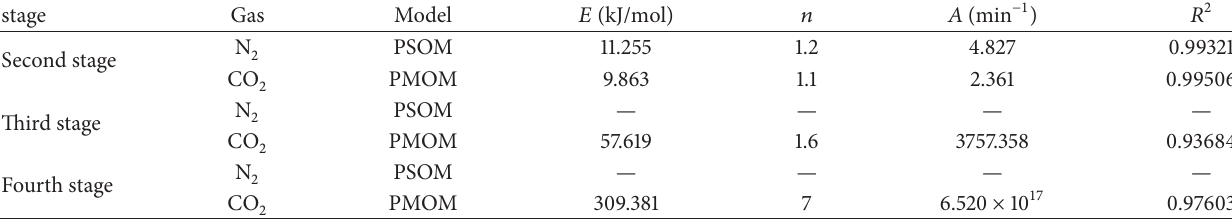
Table 5: Kinetic parameters of Chlorella vulgaris at heating rate of 10 ∘ Cmin −1